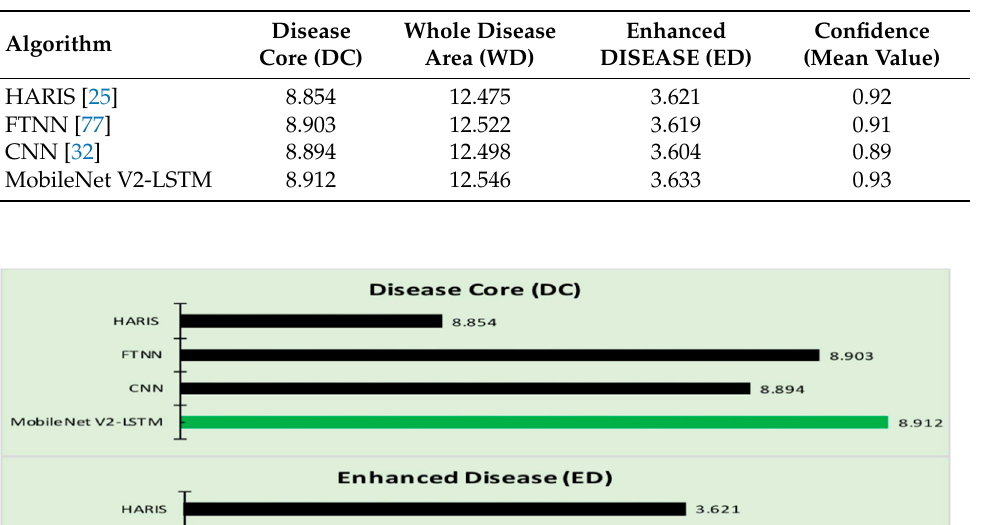
Table 5. The progress of the disease growth.